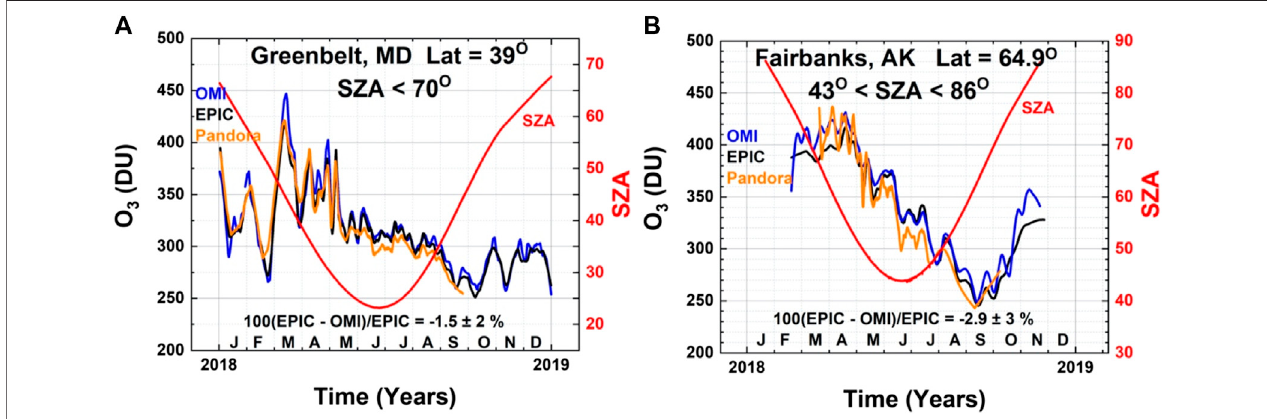
FIGURE 10 | Comparisons of EPIC TOZ (in DU) with ground-based Pandora and satellite OMI TOZ measurements in 2018 at two locations: (A) Greenbelt, MD, United States and (B) Fairbanks, Alaska, United States. Plots show time series of TOZ measurements derived by fi tting the LOESS (equivalent to a 3-weeks moving average) to all available EPIC (black lines), Pandora (orange) and OMI (blue) measurements at both locations. The red curve shows the average SZA for all EPIC measurements with a scale shown on the right hand. At Greenbelt only EPIC measurements with SZA < 70 ° were used, while at Fairbanks all available EPIC measurements were